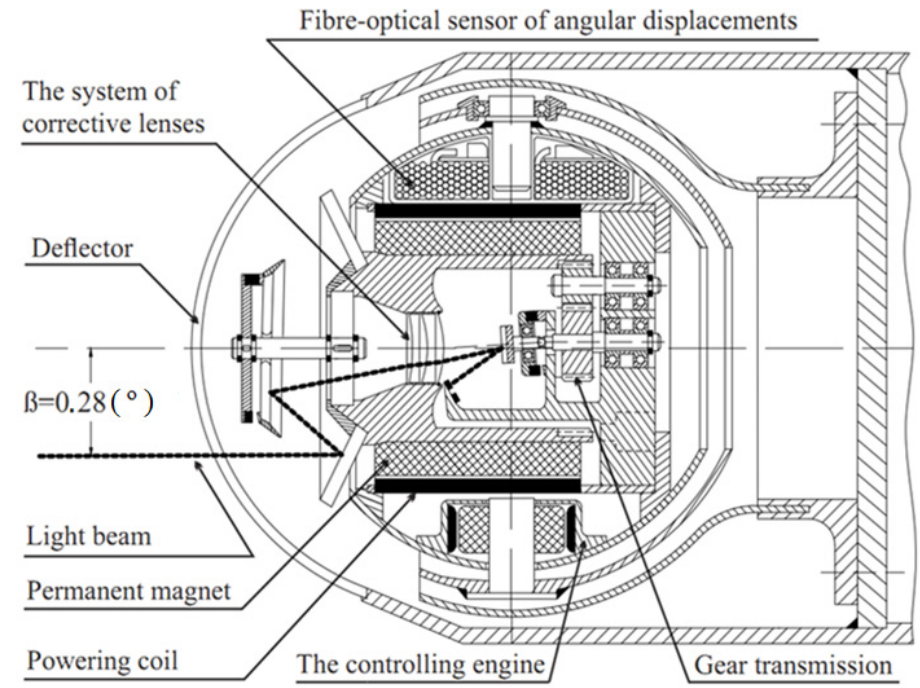
Figure 4. Scanning and tracking seeker set in the second operating mode. The detailed principle of operation and innovation of the seeker is presented in